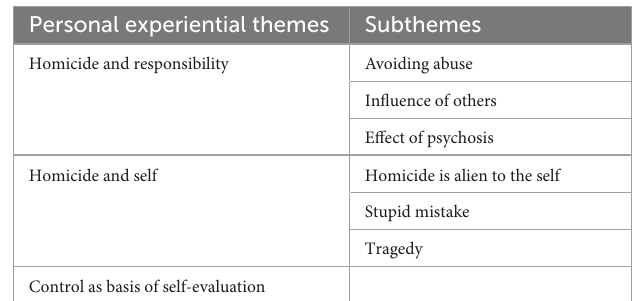
TABLE 2 Personal experiential themes and